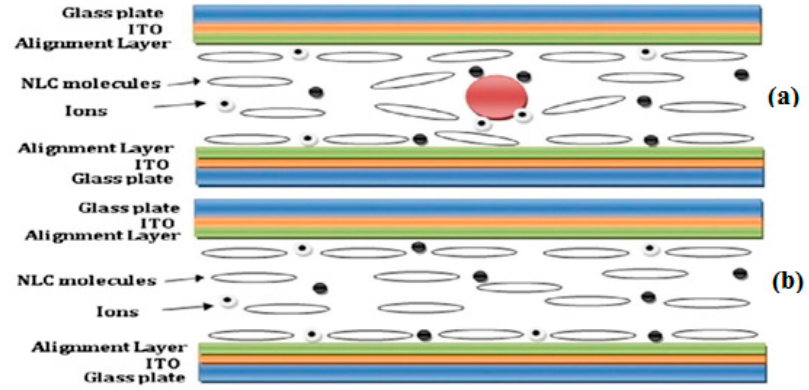
Figure 5. Schematic representations of ions impurities trapping mechanism, ( a ) in the presence and ( b ) in the absence of NPs. White circles with black spot represent the positive ions, black spots the negative ions and big red circle the NPs [4].